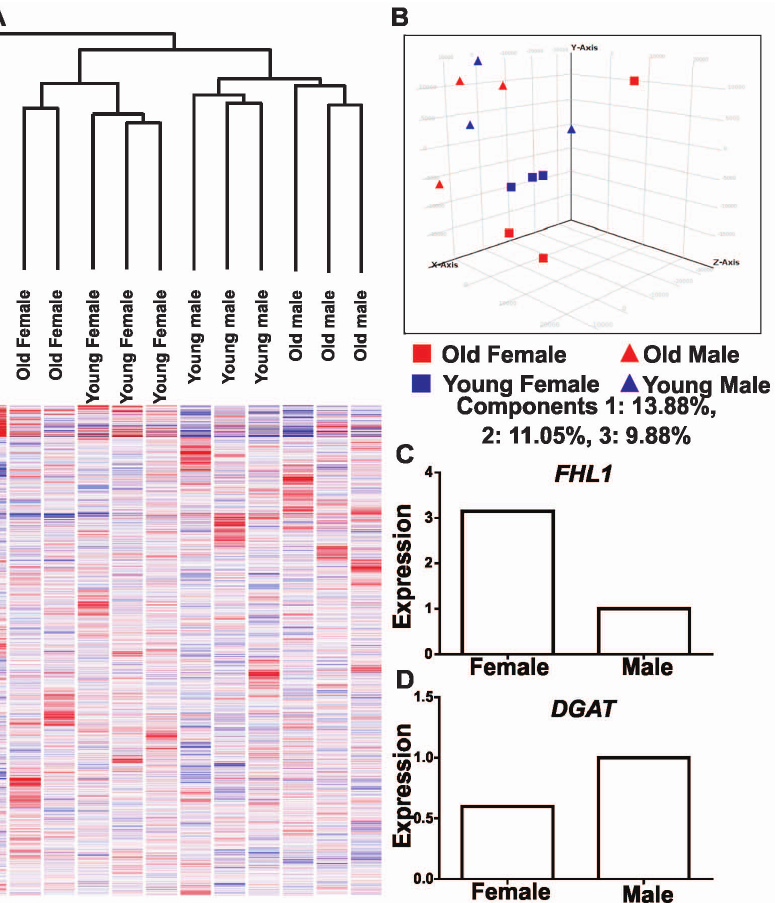
Figure 1. Affymetrix microarray analysis identifies differentially expressed genes in male vs. female and old vs. young African elephant visceral adipose tissue. Hierarchical clustering (A) and principal component analysis (B) shows that samples cluster according to age and sex. Two differentially expressed genes identified by array analysis (A), DGAT and FHL1 were selected for validation by qRTPCR in male (N=3) and female (N=3) elephants.